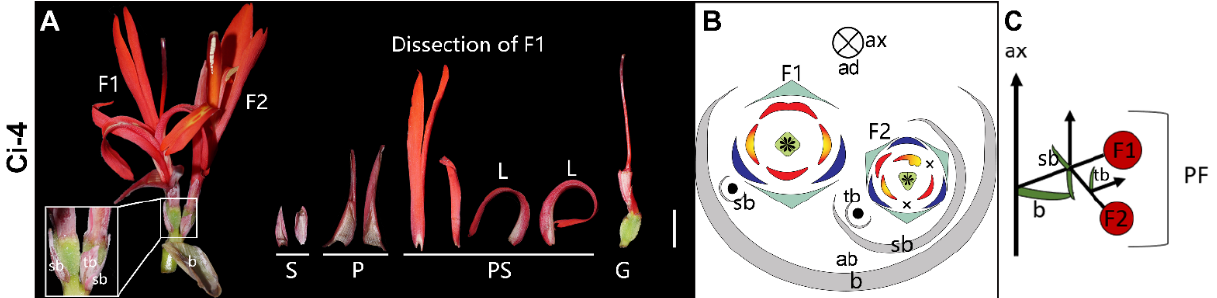
Figure 5. 1-flowered cyme. ( A ) Photograph and ( B ) diagram of the partial inflorescence of Ci-2. ( C ) Photograph and ( D ) diagram of the partial inflorescence in Ci-3. ( E ) Longitudinal scheme of the 1-flowered cyme. Bars = 1 cm.